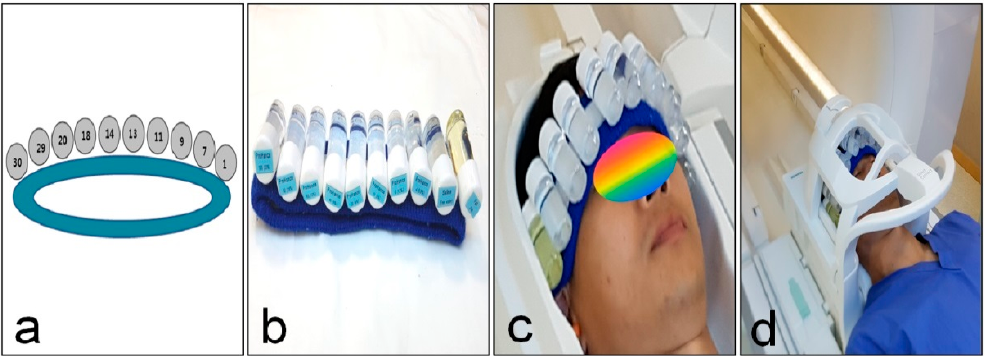
Figure 3. Images of the clinical study, ( a , b ) clinical phantom design and photographs; ( c , d ) the setup of the clinical study.